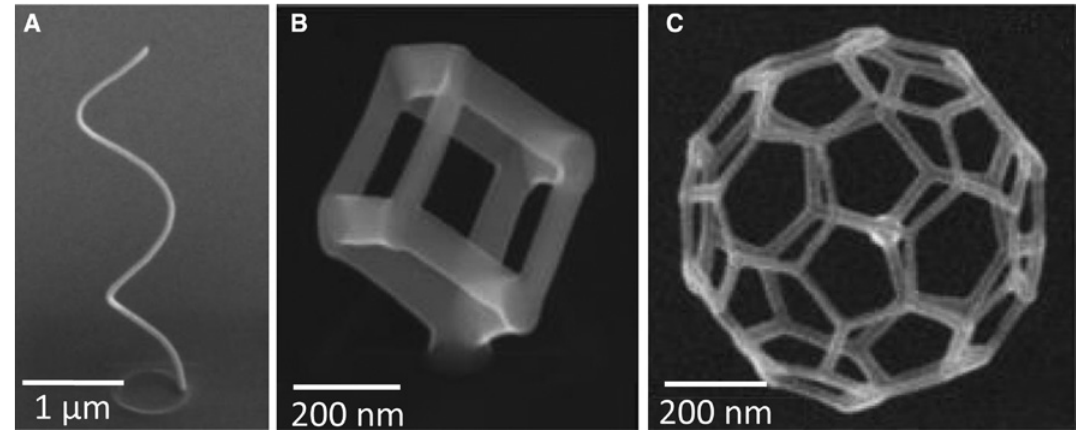
Figure 3: SEM images of free-form 3D structures fabricated by FEBID: (A) a nanospiral [71], (B) a cubic frame, and (C) a buckyball